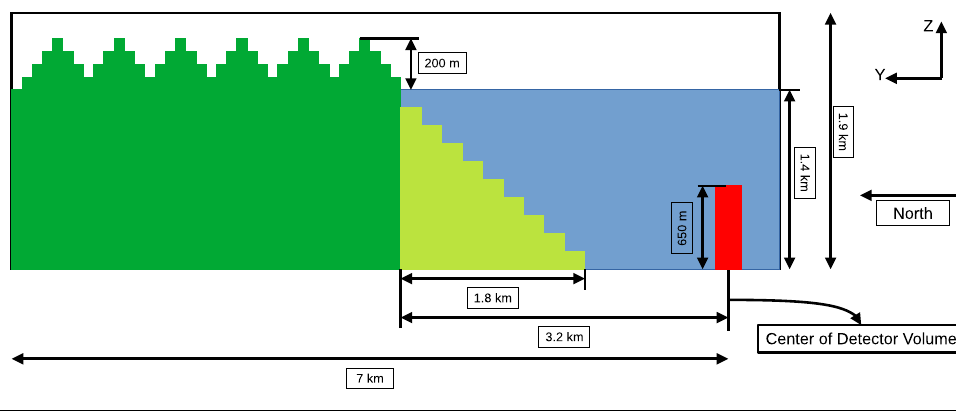
Figure 3. YZ view of the schematics of the geometry used in the